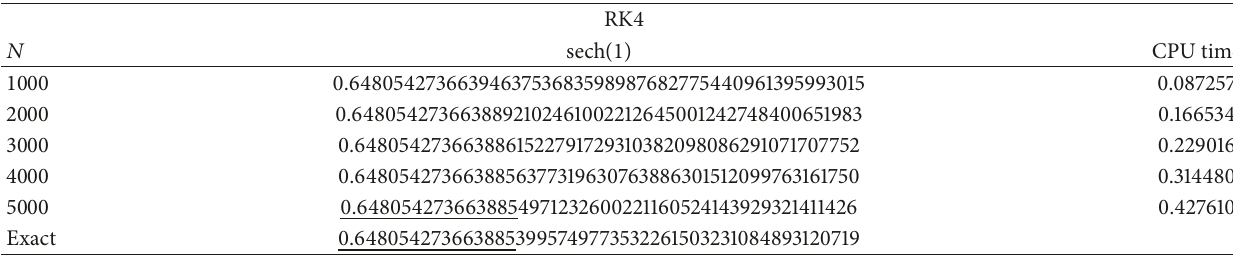
Table 1: RK4 sech (𝑥) solution of the NLSE, (29), computed at 𝑥 = 1 .